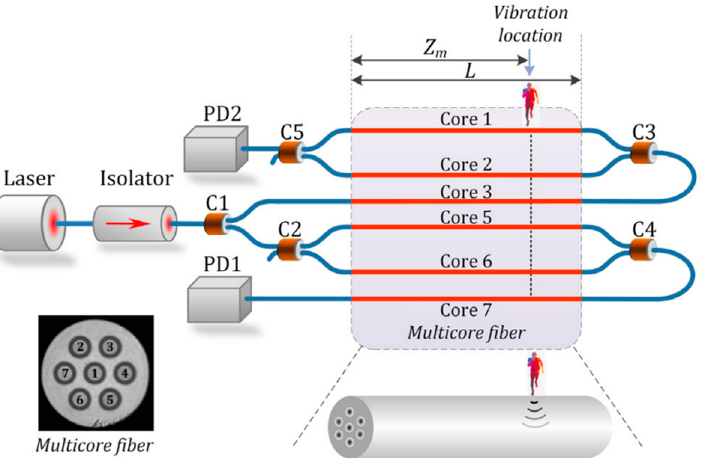
Figure 18. Schematic diagram of the proposed long ‐ range distributed vibration sensor. The inset shows the cross ‐ sectional view of the MCF used. C1–C5: optical couplers [45].